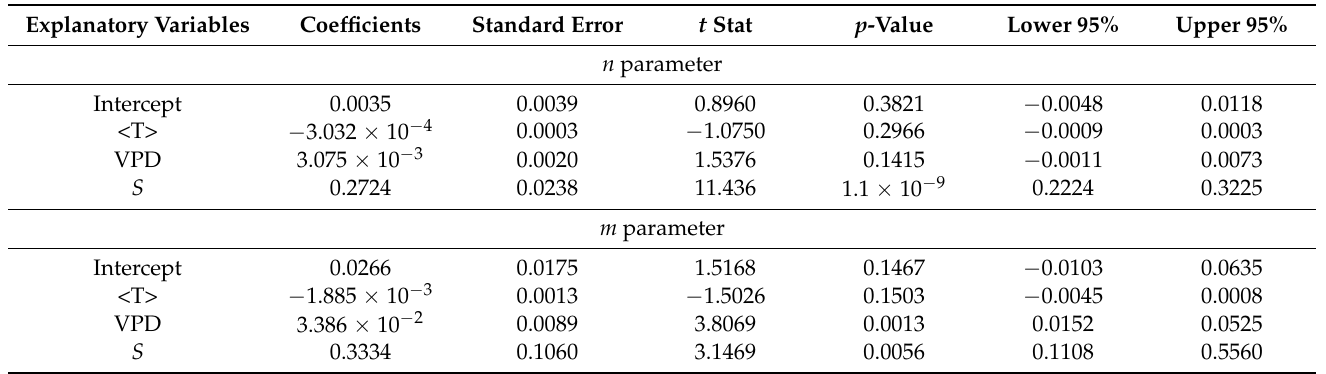
Table 4. For n and m parameters, ANOVA of the explanatory